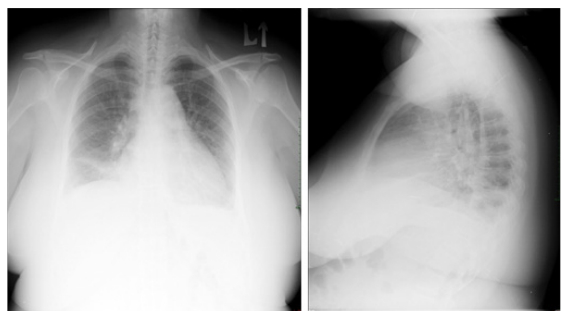
Figure 2. Chest radiography showing left hilar lymphadenopathy with right lung low zone